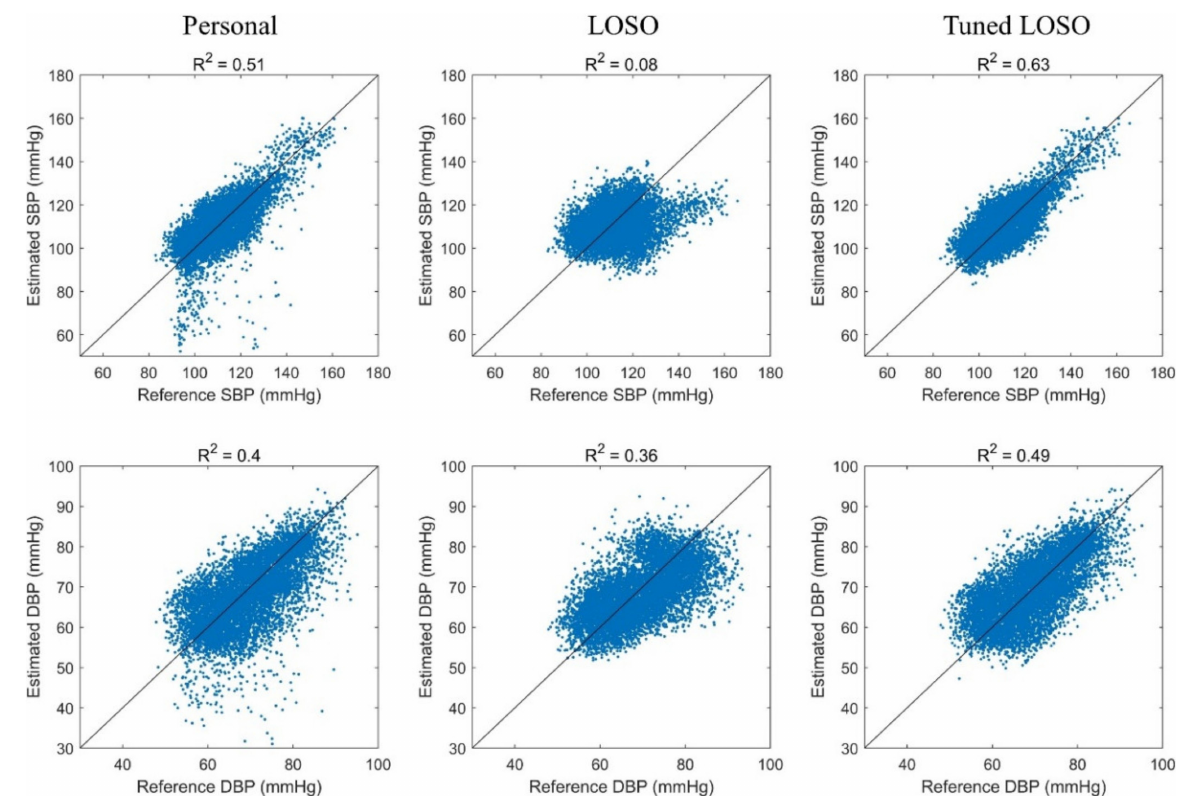
Figure 7. Scatter plots of reproducibility